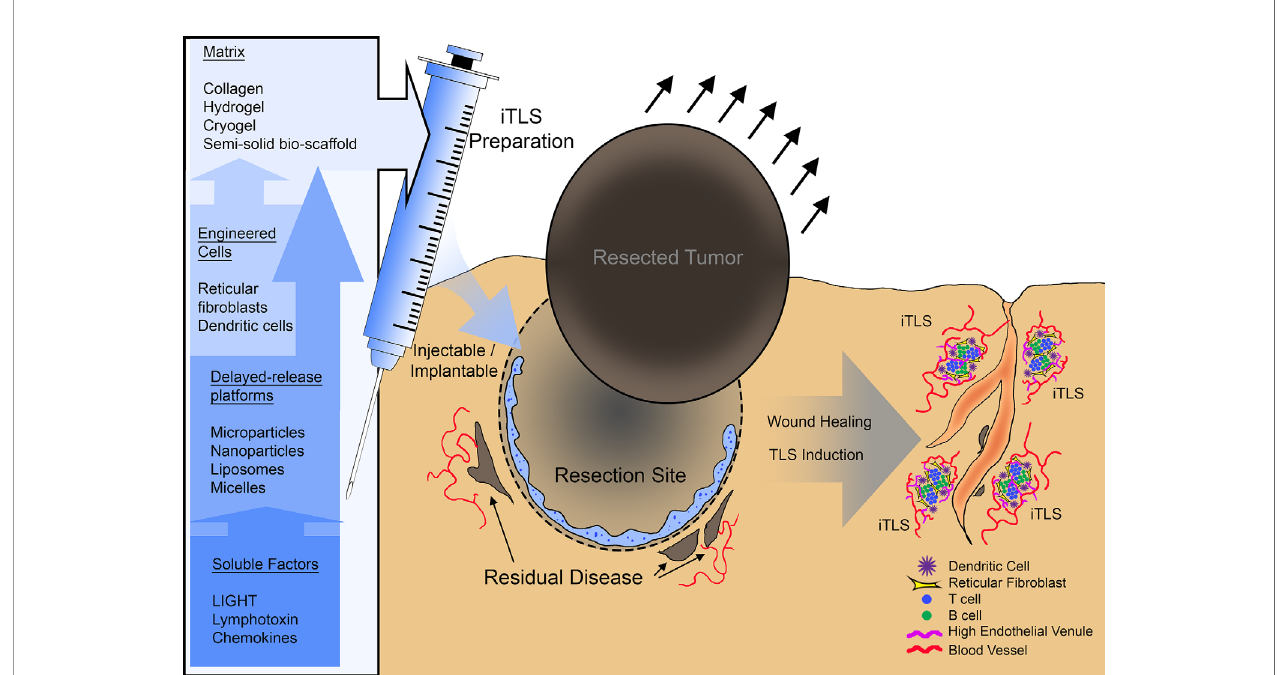
FIGURE 1 | A summary schematic of potential therapeutic use of inducible tertiary lymphoid structures (iTLS). iTLS preparations may include cellular components such as dendritic cells, or reticular fi broblasts modi fi ed to engage the LTBR pathway, or co-delivered with soluble LTBR-ligands via a delayed-release platform such as liposomes, nanoparticles, or micelles. Injectable or implantable iTLS preparations could be administered at the site of tumor resection to induce TLS and subsequently control residual disease or counteract